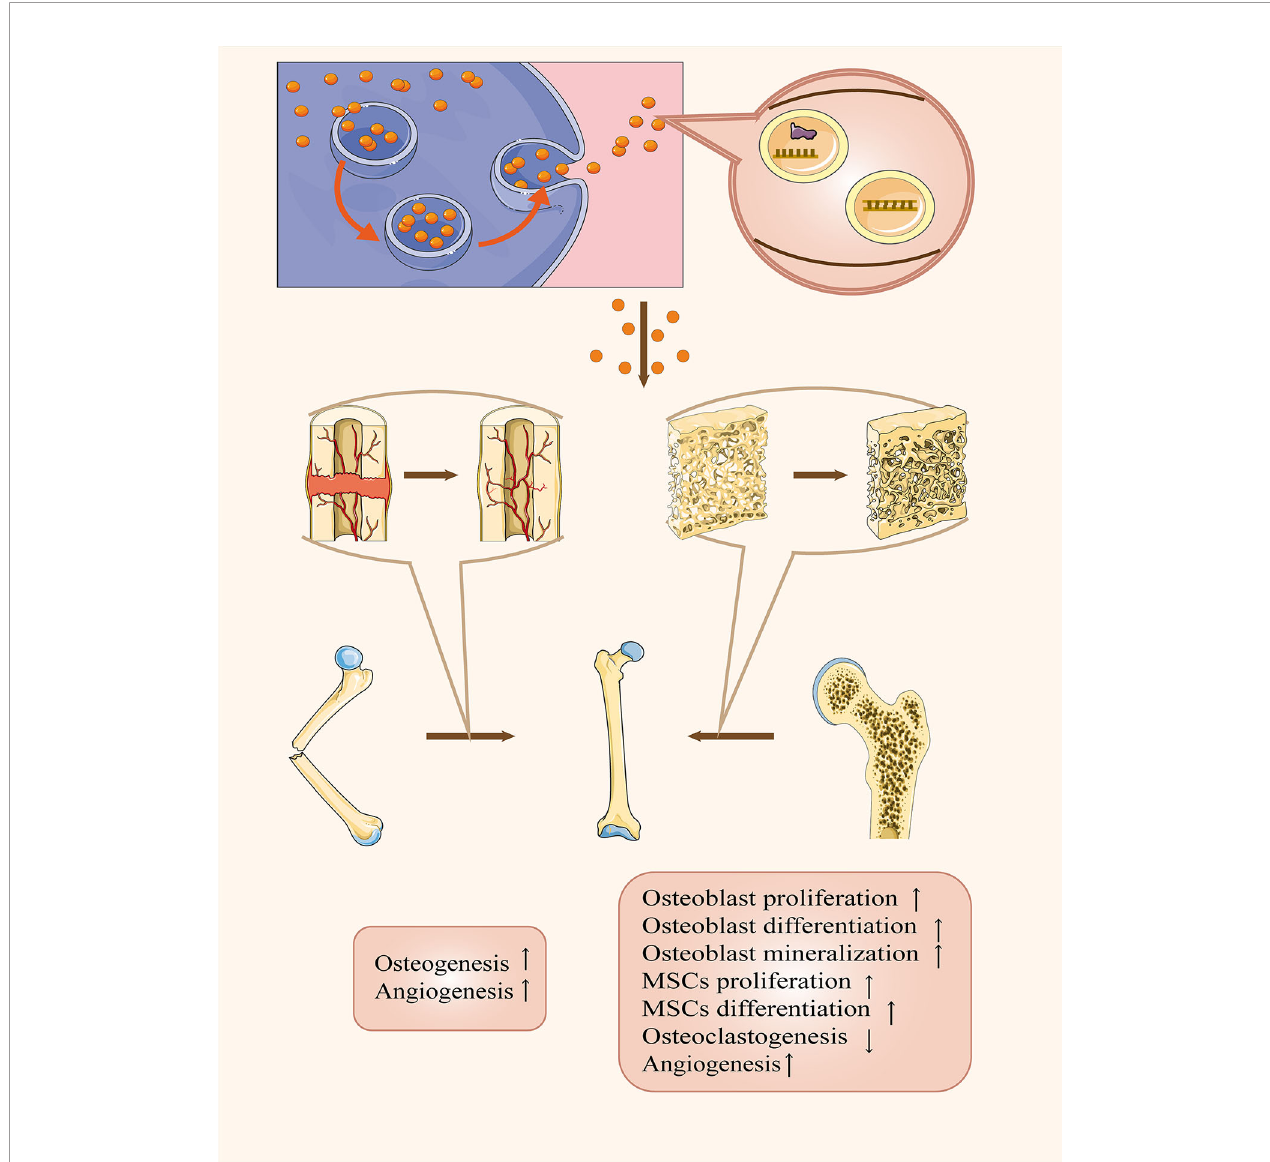
FIGURE 2 | The therapeutic applications of exosomes in OP and related fracture healing. Exosomes can act as therapeutic agents or drug carriers not only to remit OP by facilitating osteoblast proliferation, differentiation, mineralization, and MSCs proliferation, differentiation and angiogenesis as well as suppressing osteoclastogenesis but also accelerating fracture healing via promoting osteogenesis and